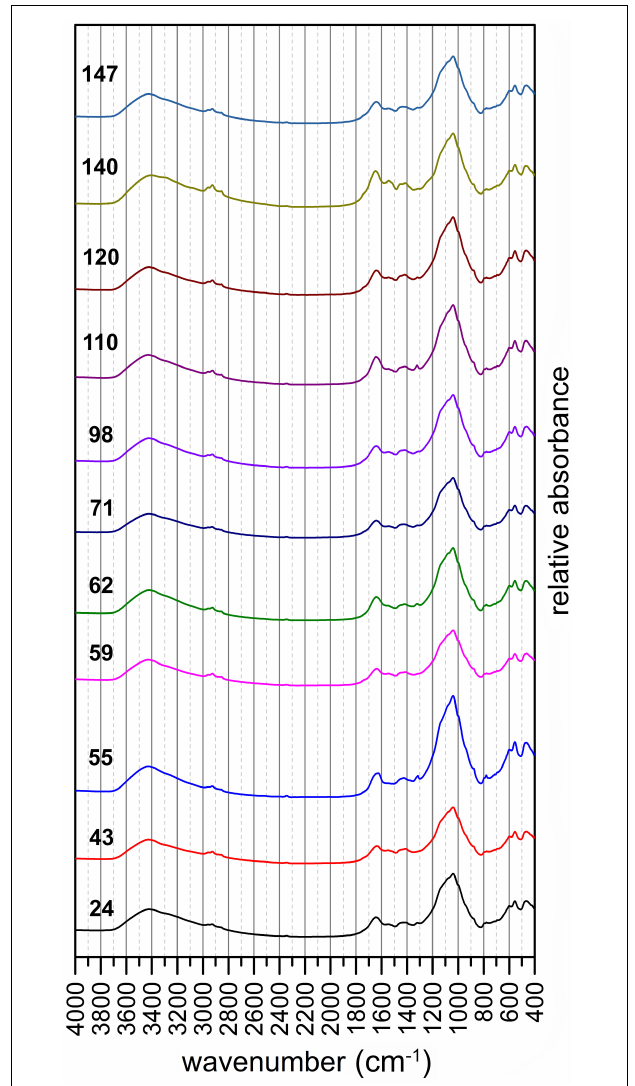
FIGURE 6 | FTIR spectra of Chlorella sp./ Aspergillus niger pellets after the adsorption experiments (values on the left indicate the amount of adsorbed